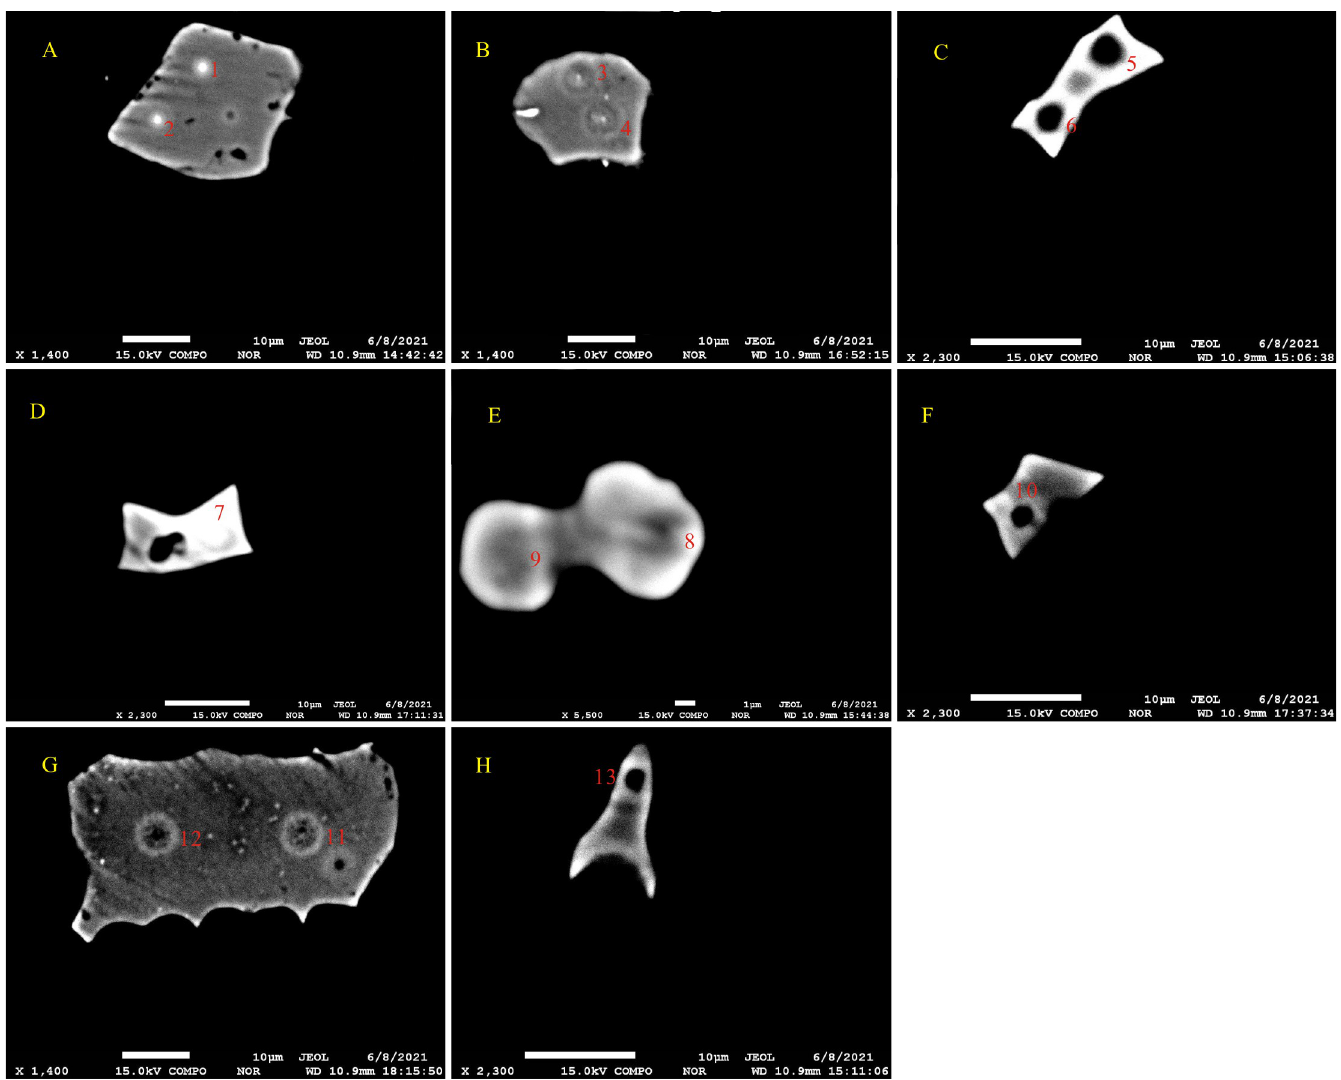
Fig 3. Back-scattered electron imaging of different phytolith morphotypes. The point numbered is focused beam hitting micro-areas of an individual phytolith particle. A, B, BULLIFORM FLABELLATE; C, D, SADDLE; E, BILOBATE; F, RONDEL; G, ELONGATE; H, ACUTE BULBOSUS. https://doi.org/10.1371/journal.pone.0270842.g003 C method (Table 4). The values of elemental compositions in phytolith varied with morpho- types and the plant species which produced the phytoliths (Tables 2 and S1A).